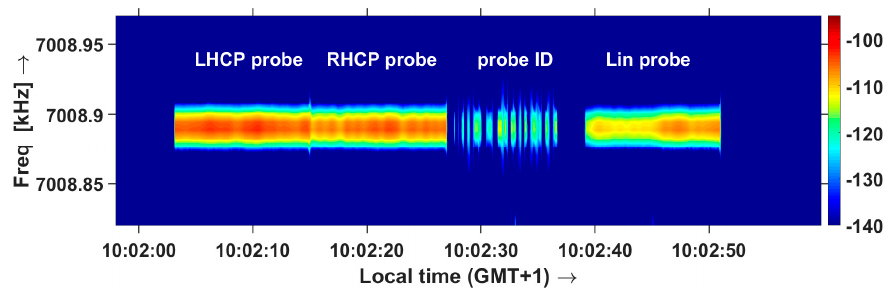
Figure 11. Spectrogram of the LHCP end RHCP waves emitted by the probe and received by the sensor on a linearly polarized antenna, during normal NVIS propagation.